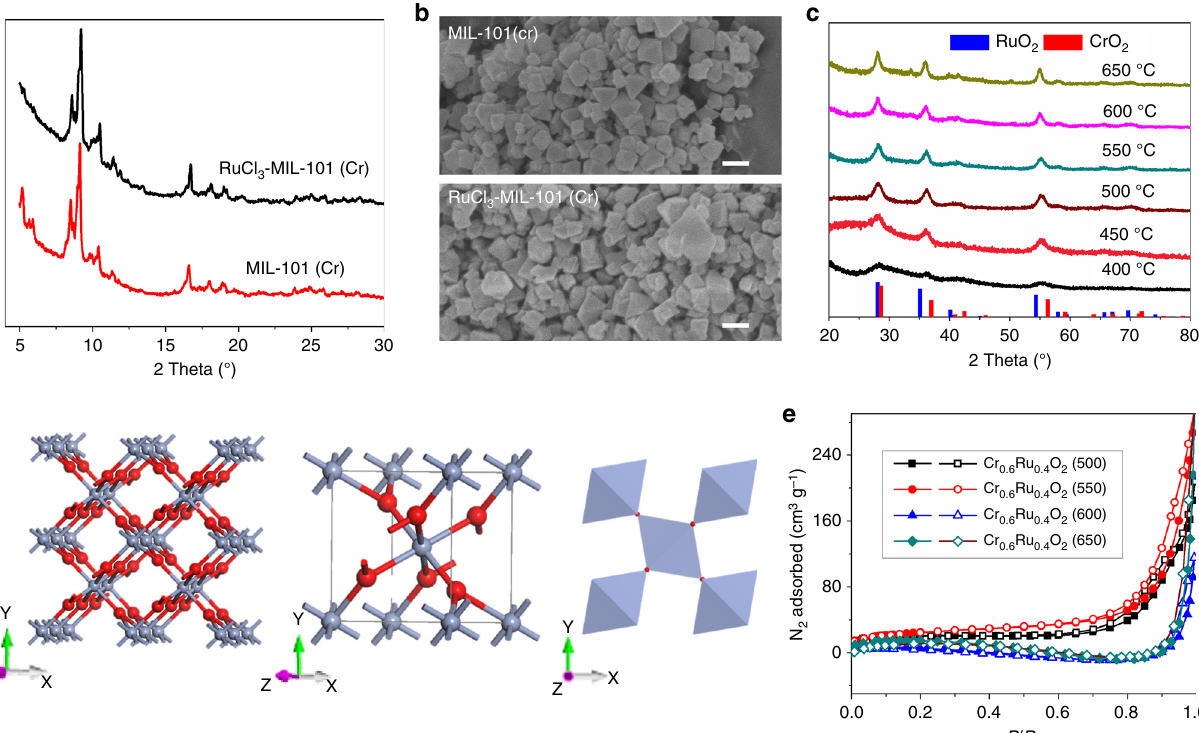
Fig. 2 Structural characterizations of RuCl 3 -MIL-101(Cr) and Cr 0.6 Ru 0.4 O 2 (550). a , b PXRD patterns and SEM images of MIL-101 (Cr) before and after loading RuCl 3 (scale bars, 200 nm); c PXRD patterns of Cr 0.6 Ru 0.4 O 2 powders annealed at different temperatures. The reference patterns of CrO 2 and RuO 2 were obtained from Jade 2004 (JCPDS No.09-0332 and 43-1027); d Crystal structure of Cr 0.6 Ru 0.4 O 2 (550): (left) packing image, (middle) unit cell, (right) corner shared octahedral MO 6 structure. Color code: blue (60% Ru, 40% Cr), red (O). e 77 K N 2 adsorption/desorption isotherms of Cr 0.6 Ru 0.4 O 2